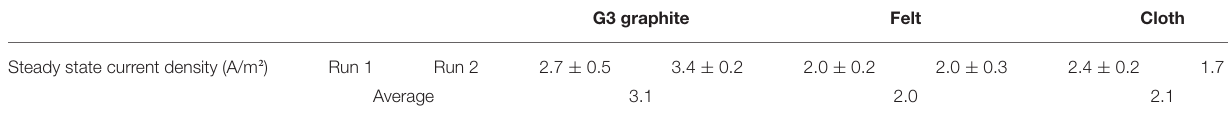
G3 graphite Felt Cloth